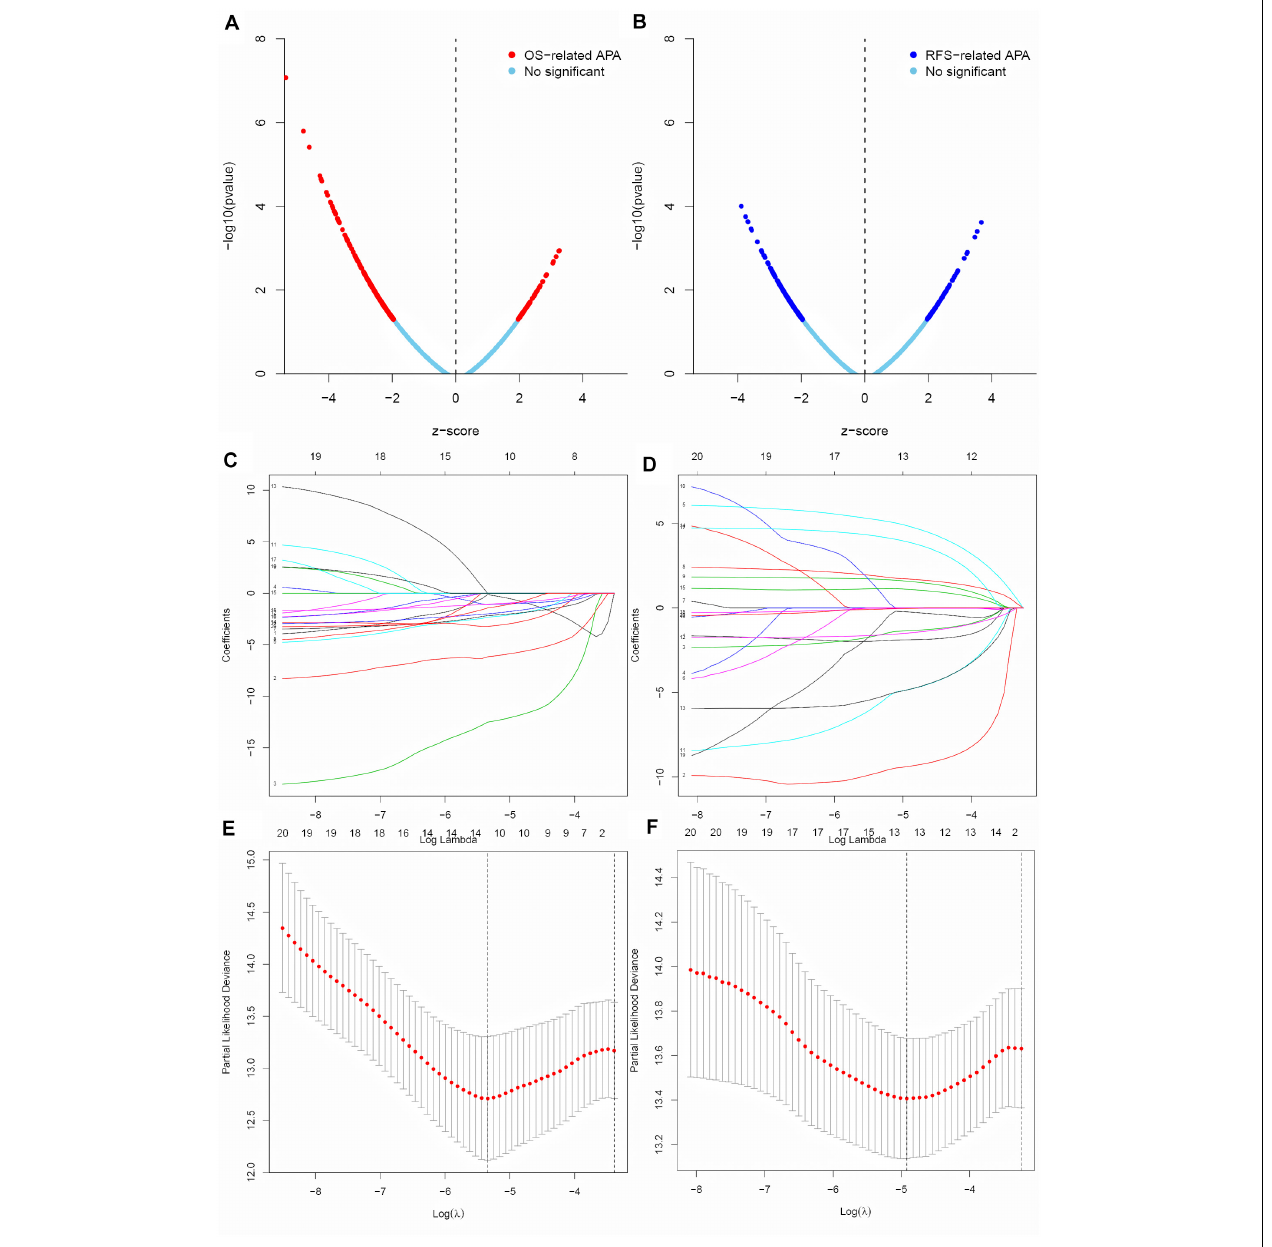
FIGURE 1 | Screen of the key prognosis-related APA events. (A,B) Volcano plot of OS-related APA events and RFS-related APA events. (C,D) Ten-fold cross-validation for tuning parameter selection in the LASSO regression for OS and RFS. (E,F) LASSO coefficient profiles of top 20 prognostic APA events for OS and